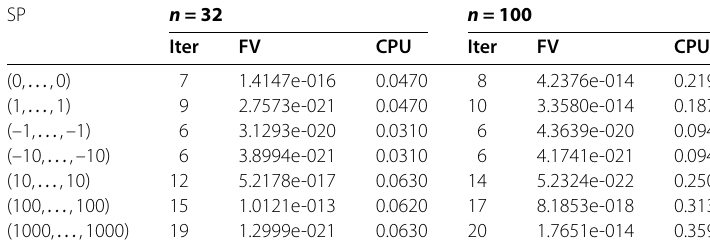
Table 3 Numerical results for Example 3